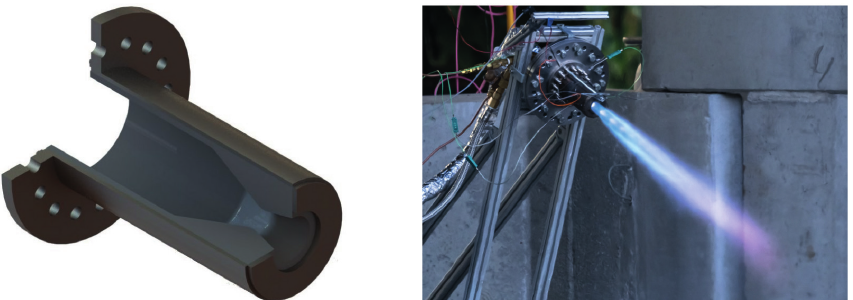
Figure 26. ( left ) sectional view of the steel combustion chamber with graphite lining and ( right ) its use in a hot test.